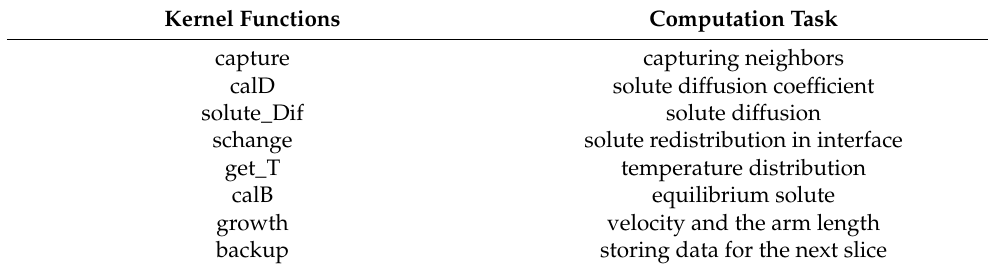
Table 1. Task assignment in GPU-CA model.